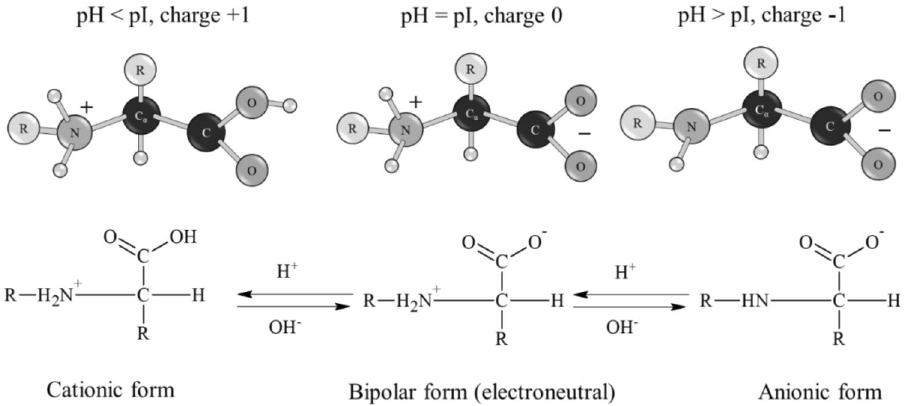
Figure 17. Protonation and deprotonation scheme of the CAPB molecule.